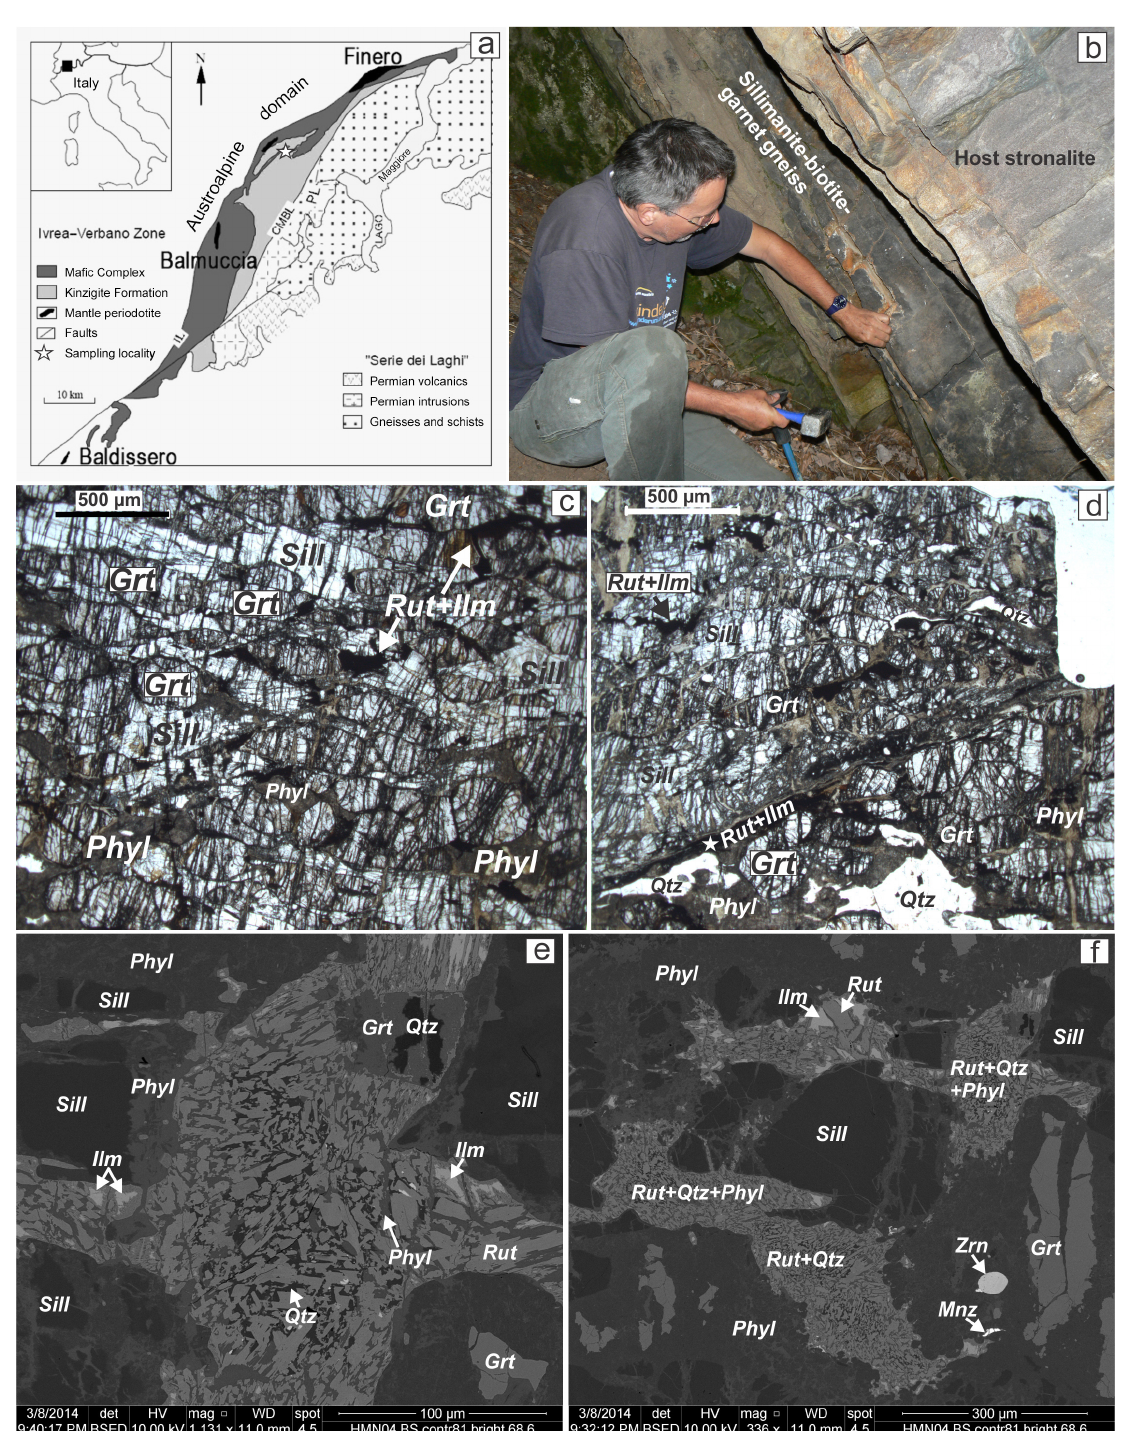
Figure 1. (a) Geological map of the Ivrea–Verbano Zone after Zanetti et al. (1999) with the sampling location indicated by a star. (b) Field photograph of the sampled outcrop with the dyke-shaped body of the sillimanite–biotite–garnet gneiss, interpreted as restitic, hosted by mylonitized and fractured stronalite. (c–d) Plain-polarized light photomicrographs. Two generations of veins are visible: black veins and pockets (Fe–Ti oxides) and brown-grey material (mixture of fine-grained phyllosilicates and K-feldspar). White star in panel (d) indicates the position of Fig. 4a. (e–f) BSE images with mineral paragenesis. Note in panel (e) that the rutile aggregate contains ilmenite cores (bright grey) and forms intergrowths with two different phases: phyllosilicates from the reaction rim (grey shade, slightly darker than rutile) and quartz (the darkest phase), all indicated by arrows. Sill: sillimanite, Grt: garnet, Qtz: quartz, Ilm: ilmenite, Rut: rutile, Rut + Qtz: rutile–quartz intergrowths, Phyl: fine-grained mixture of phyllosilicates, Zrn: zircon detrital grain, and Mnz: monazite. Solid Earth, 8, 789–804, 2017